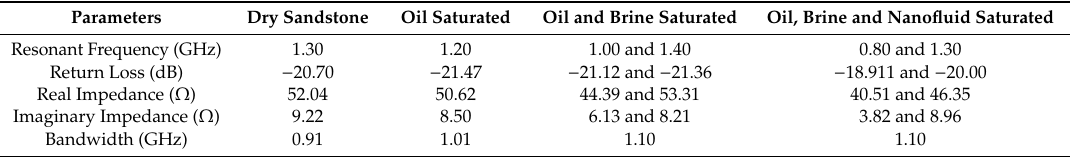
Table 3. Antenna characteristics at di ff erent